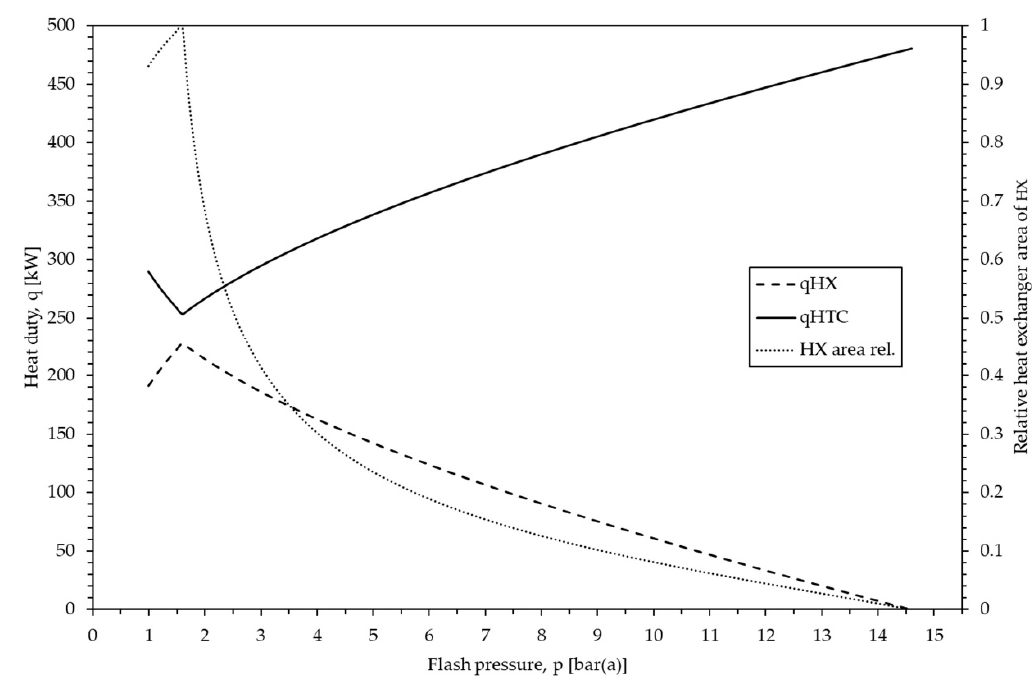
Figure 3. Sensitivity analysis of the flashing pressure for the heat exchanger and the reactor heat duty, as well as the heat exchanger area of HX.